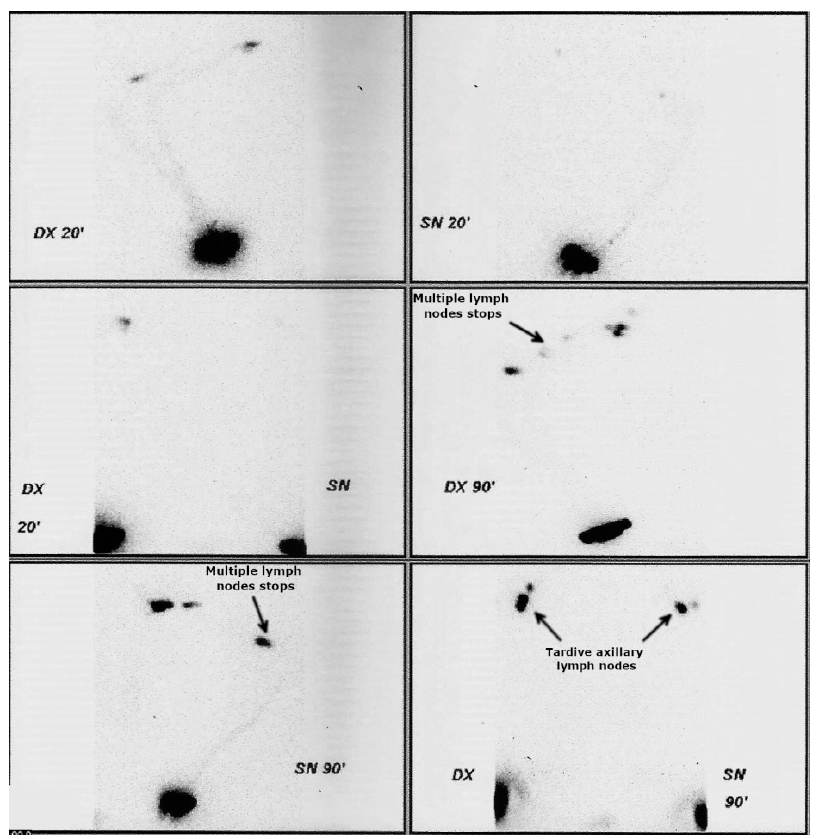
Figure 3. Lymphoscintigraphy of father of the proband with c.580T > C variants in NRP2 (family 1). Although phenotypically healthy, lymphoscintigraphy highlighted subclinical anomalies (arrows): radiotracer accumulates in multiple lymph nodes of the left (panel 4) and right arm (panel 5). After 90 min of tracer administration, there is reduced tardive visualization of the right axillary lymph nodes (right axillary packet hypogenesis) and even more reduced tardive visualization of the left axillary lymph nodes (left axillary packet hypogenesis) (arrows in panel 6).